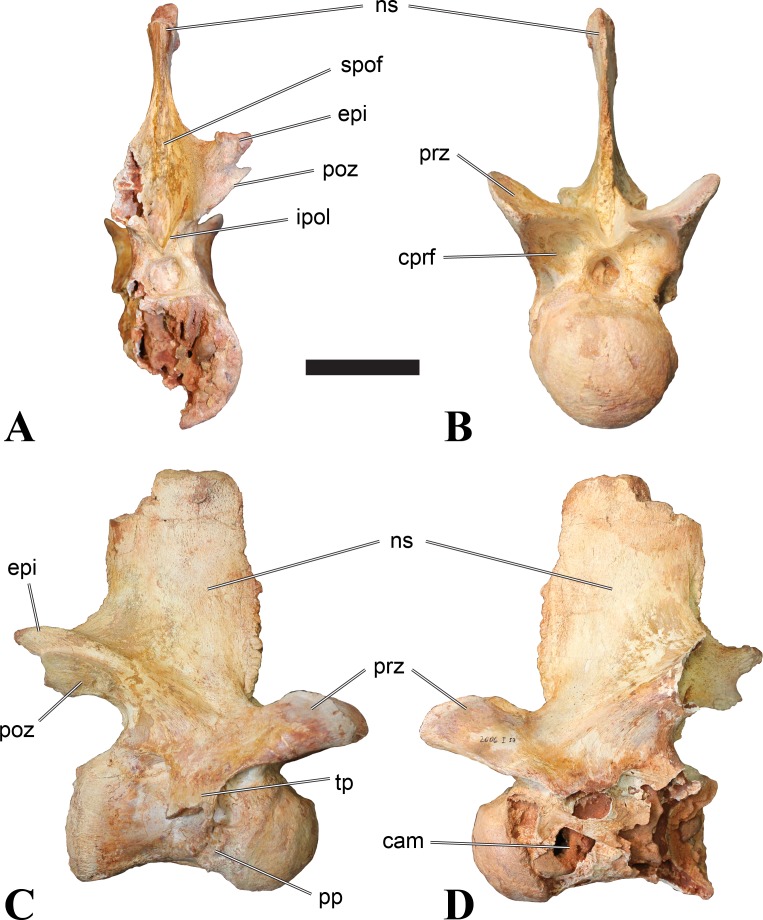
BSPG 2006 I 57, mid-cervical vertebra (C6) of an indeterminate spinosaur.(A) posterior view; (B) anterior view; (C) right lateral view; (D) left lateral view. Abbreviations: cam, camerate pneumatic chamber; cprf, centroprezygapophyseal fossa; epi, epipophysis; ipol, interpostzygapophyseal lamina; ns, neural spine; poz, postzygapophysis; pp, parapophysis; prz, prezygapophysis; spof, spinopostzygapophyseal fossa; tp, transverse process. Scale bar equals 5 cm.